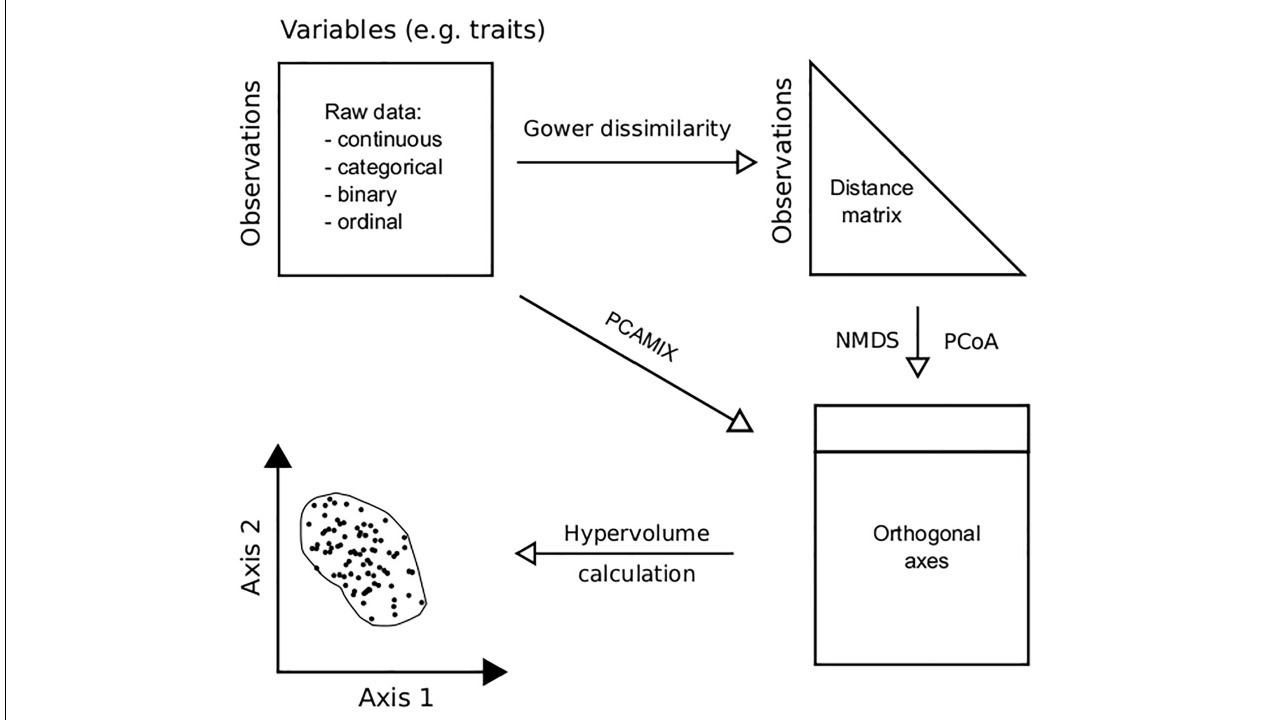
FIGURE 2 | Diagram showing the construction of axes to be used in hypervolume estimation. The axes are obtained by ordination for mixed data types (PCAMIX; see Chavent et al., 2017) or by performing a PCoA or NMDS carried on a Gower dissimilarity matrix of individuals X